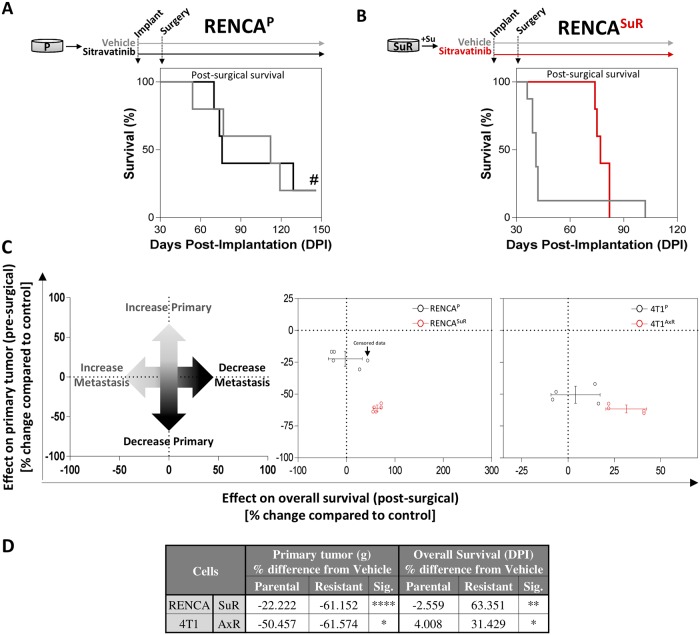
Perioperative sitravatinib treatment improves survival in TKI-resistant models of spontaneous metastatic disease.(A-B) Mice received orthotopic implantation in kidney of P or SuR tumor cells for RENCAP and RENCASuR (Balb/c mice; n = 5–8) models. Sitravatinib was administered to mice bearing (A) RENCAP, and (B) RENCASuR tumors and stopped at the end of the experiment. Post-surgical survival is shown. (C) Combined analysis showing differences in pre-surgical primary tumor and post-surgical metastatic burden for 4T1P and RENCAP (black dots); and 4T1AxR and RENCASuR (red dots) treated with vehicle or sitravatinib (Balb/c mice; n = 4). Crossed lines represent the standard deviation of sitravatinib-treated P (black cross) and SuR/AxR (red cross) cell-implanted tumor model data derived from comparisons of primary tumor burden data (vertical line) and median survival data (horizontal line). (D) Corresponding values for percent differences in primary tumor burden (tumor or tumor-bearing kidney weight) and overall survival (days post-implantation) are shown. Significance was assessed by student’s t test comparing SuR/AxR vs. P cell-implanted animals treated with sitravatinib and normalized to corresponding vehicle-treated animals. Tx, treatment; DPI, days post implantation; P; parental; SuR, sunitinib-resistant; AxR, axitinib-resistant; Su, sunitinib; Ax, axitinib; TKI, tyrosine kinase inhibitor; g, grams; Sig, significance. Mean ± standard deviation (SD); * p<0.05, ** p<0.01, *** p<0.001, **** p<0.0001 compared to vehicle-treated mice or P cell-implanted model. # represents disease-free survival until experiment end (indicated as ‘censured’ in Fig 4C).